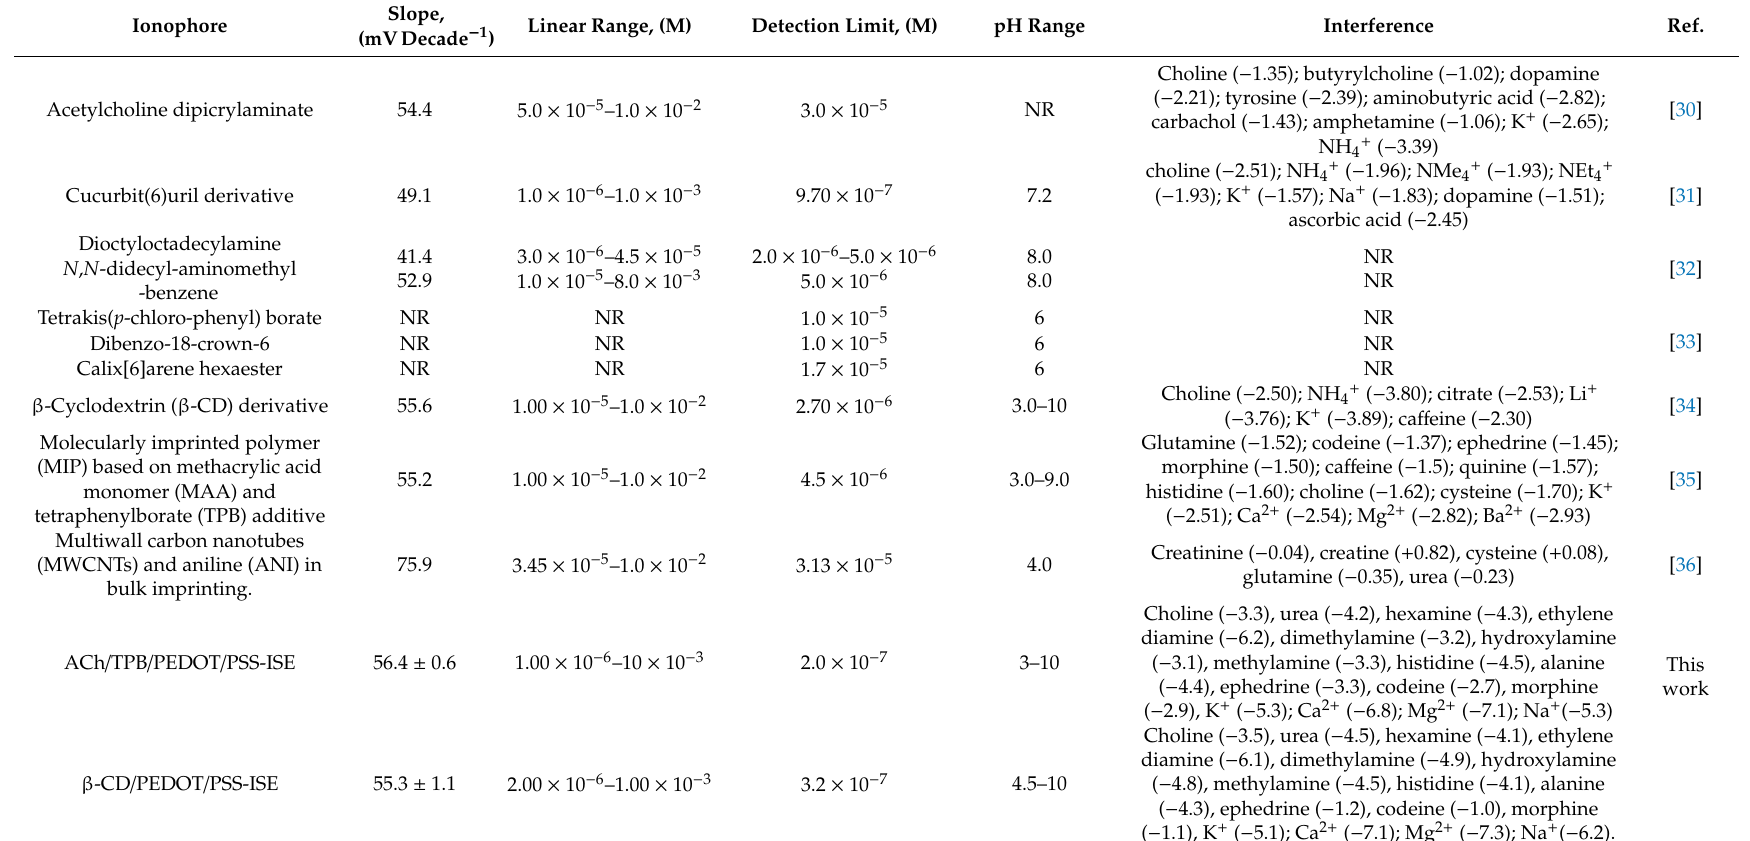
Table 1. General characteristics of some potentiometric sensors for acetylcholine